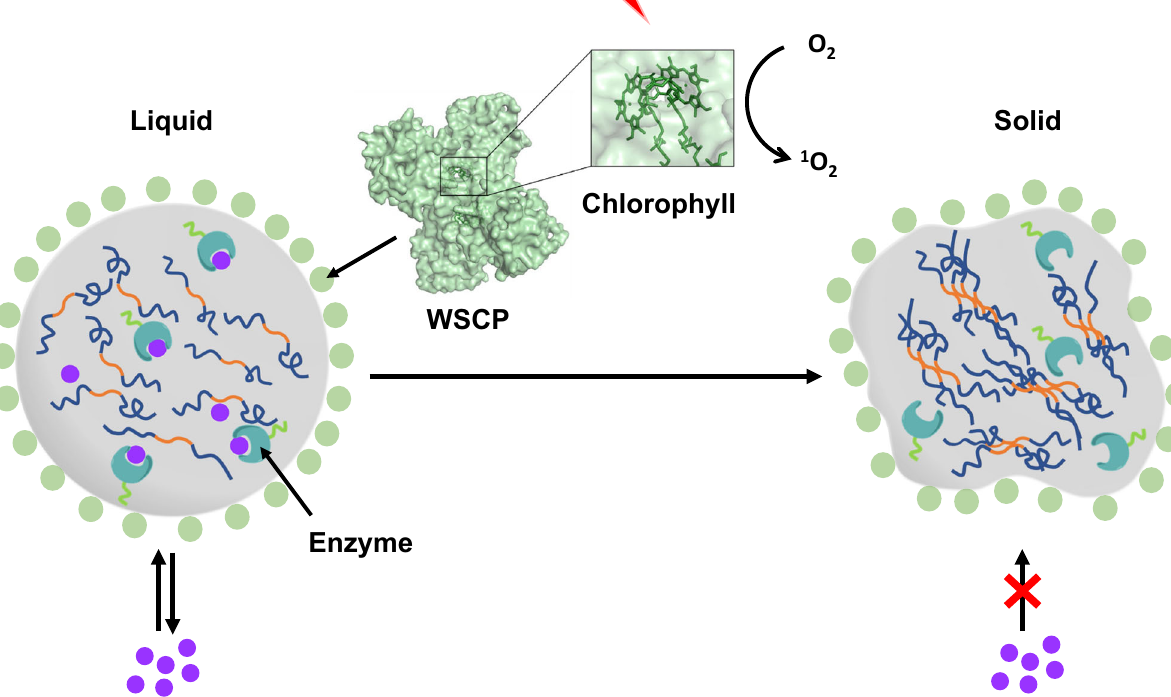
Fig. 1 Schematic illustration of a red-light-controlled protein condensate enabled by water-soluble chlorophyll-binding protein (WSCP). The protein condensate formed via LLPS of RGG-Mfp-3-RGG (RMR) is decorated with WSCP (PDB: 2DRE), a tetrameric protein that generates singlet oxygen ( 1 O 2 ) under red light irradiation. Upon photooxidation, the protein condensate undergoes a liquid-to-solid phase transition, which restricts the diffusion of substrates into the enzyme-laden protein condensate and turns off the catalysis within.